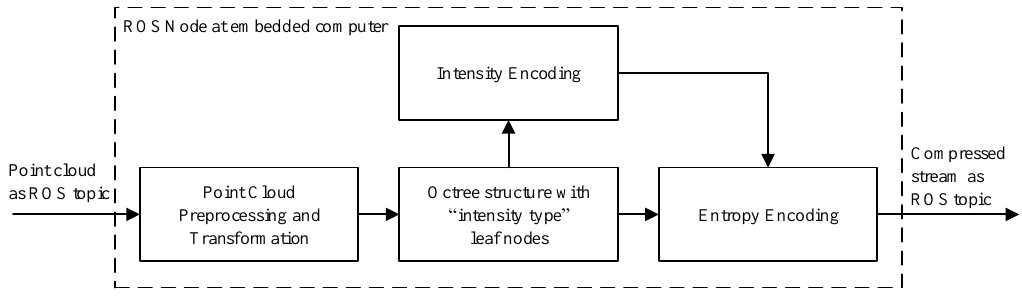
Figure 3. Schematic overview of the compression principle implemented as an ROS node at the embedded